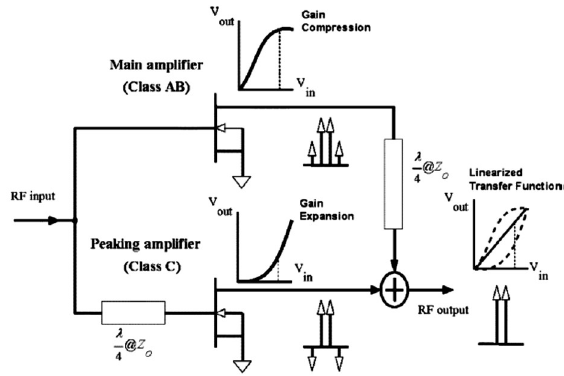
Figure 11. Linearization scheme of Doherty PA using post-distortion [79].